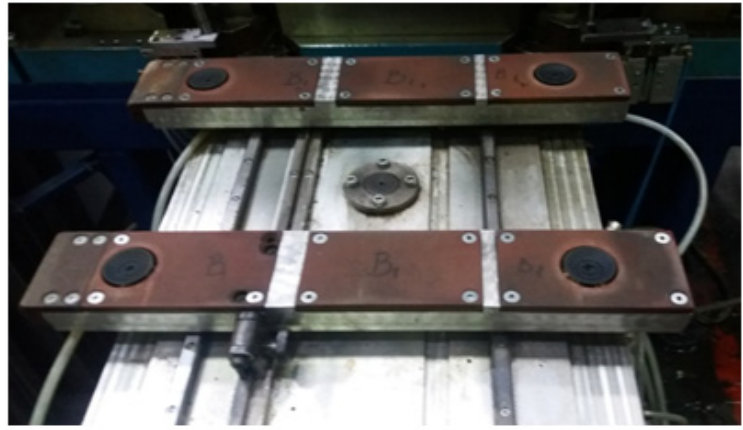
Figure 24. The new device for centering.